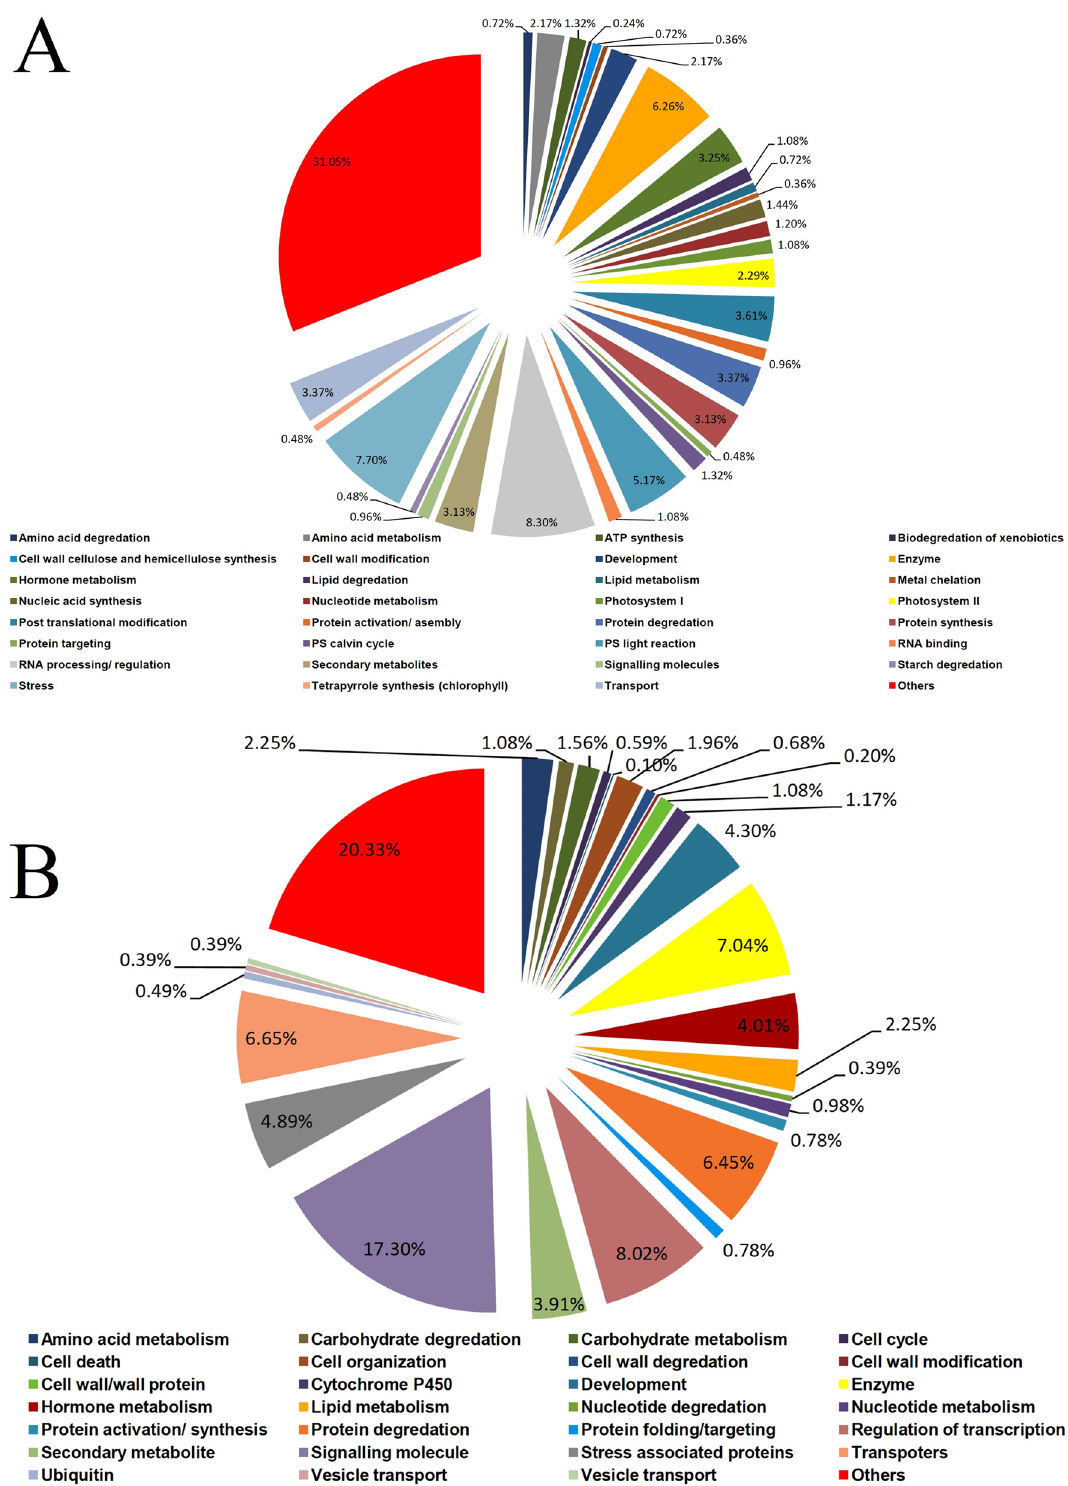
Figure 12. Category wise distribution of differentially expressed ( A ) up-regulated and ( B ) down-regulated genes on annotation with Arabidopsis